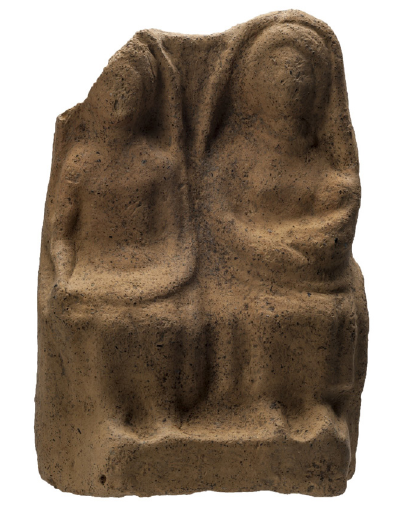
Figure 6. Veii Campetti. © MiBAC. Museo Nazionale Etrusco di Villa Giulia. Foto Mauro Benedetti. From Pedrucci, “Maternità e allattamento”. One more statuette (possibly two) from Rome (from the so-called votive deposit of Minerva Medica)26 is very interesting (Fig. 7). It represents an enthroned male, female and child likely beneath the same mantle (heads are missing). Likely, the man has his left arm on the woman’s shoulders and he holds a patera in the other hand. Feet are on a footrest. The position of the baby is quite unusual: it is seated in the woman’s lap in three quarter profile. Even if it is almost frontal, it lifts its right hand to grab the breast and indeed seems to squeeze the nipple.27